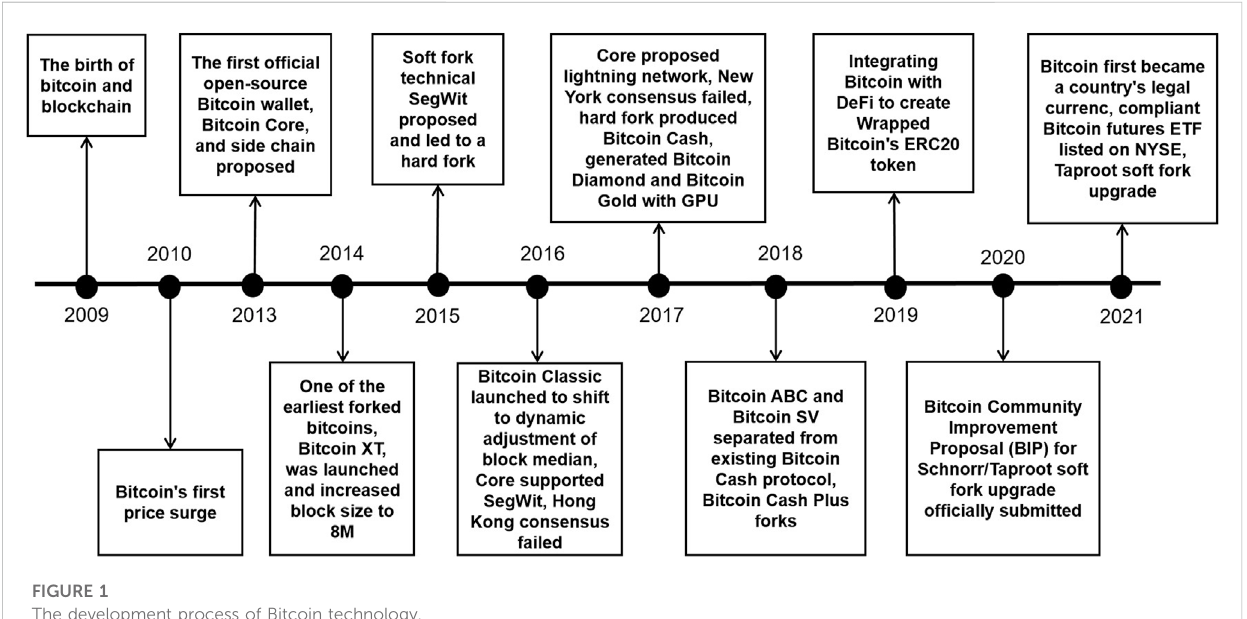
FIGURE 1 The development process of Bitcoin